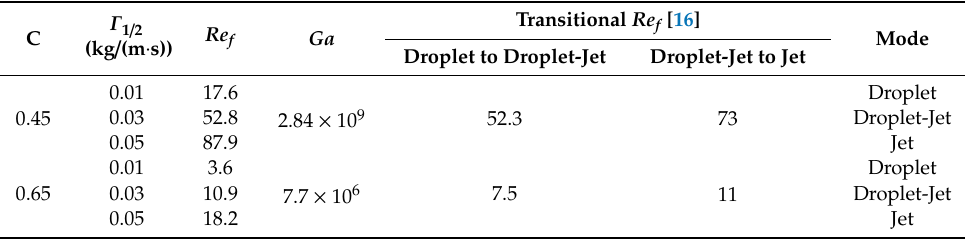
Table 2. Films Reynolds number Re f and flow modes for all cases.